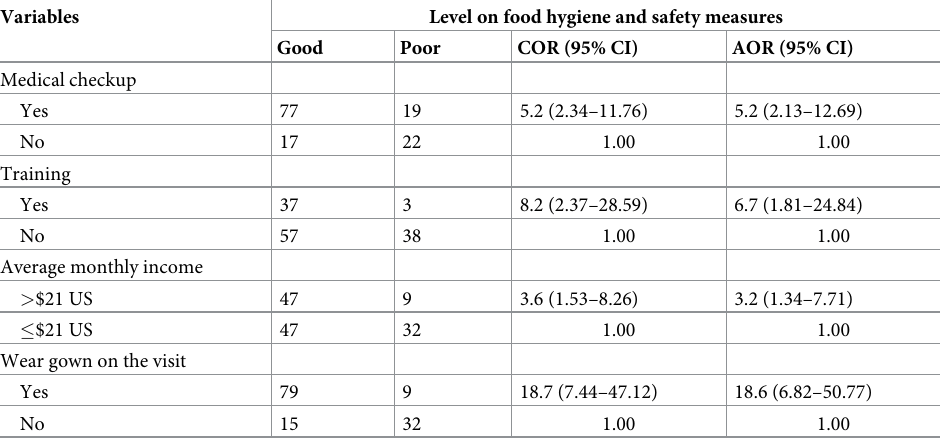
Table 6. Factors significantly associated with good level of food hygiene and safety measures among street food vendors and food handlers in food establishments in multivariable logistic regression analysis from December 2013 to June 2014, Dessie town,